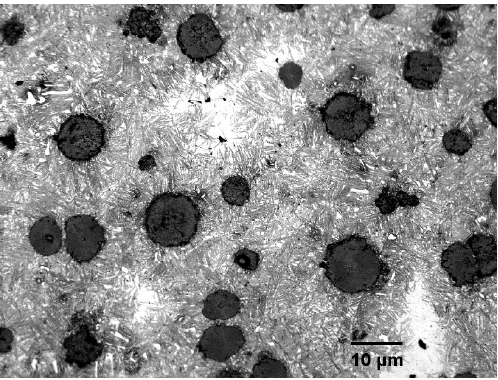
Figure 7. Microstructure of nodular cast iron normalized at 900 °C.